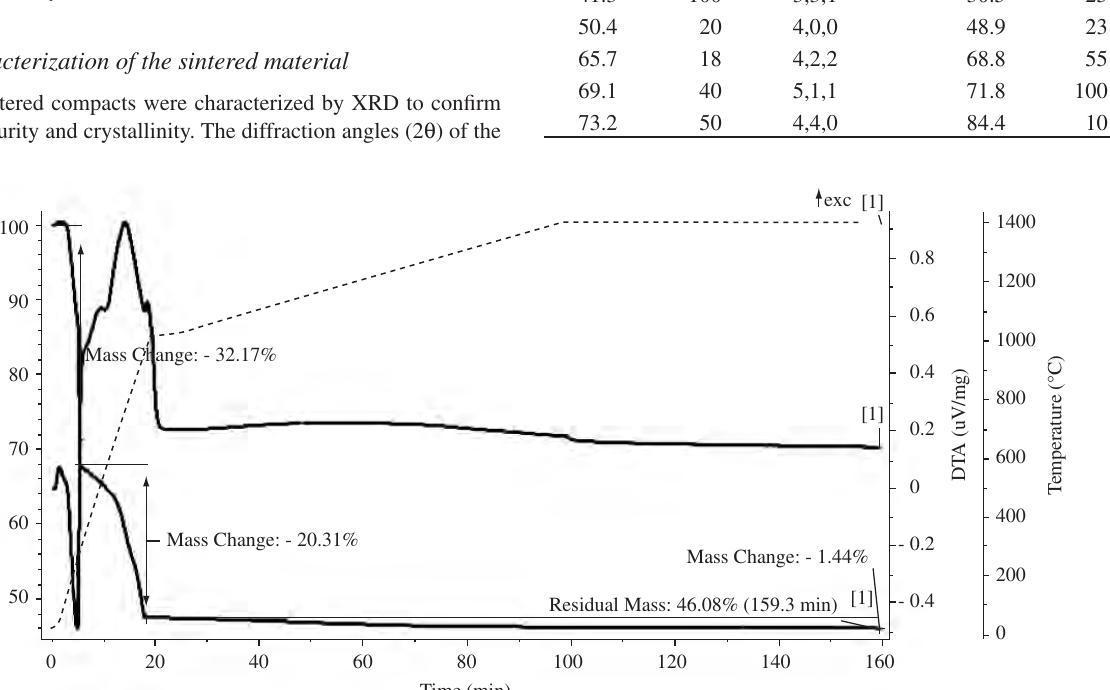
(Table 1), based on the X ray diffraction pattern. The values remained